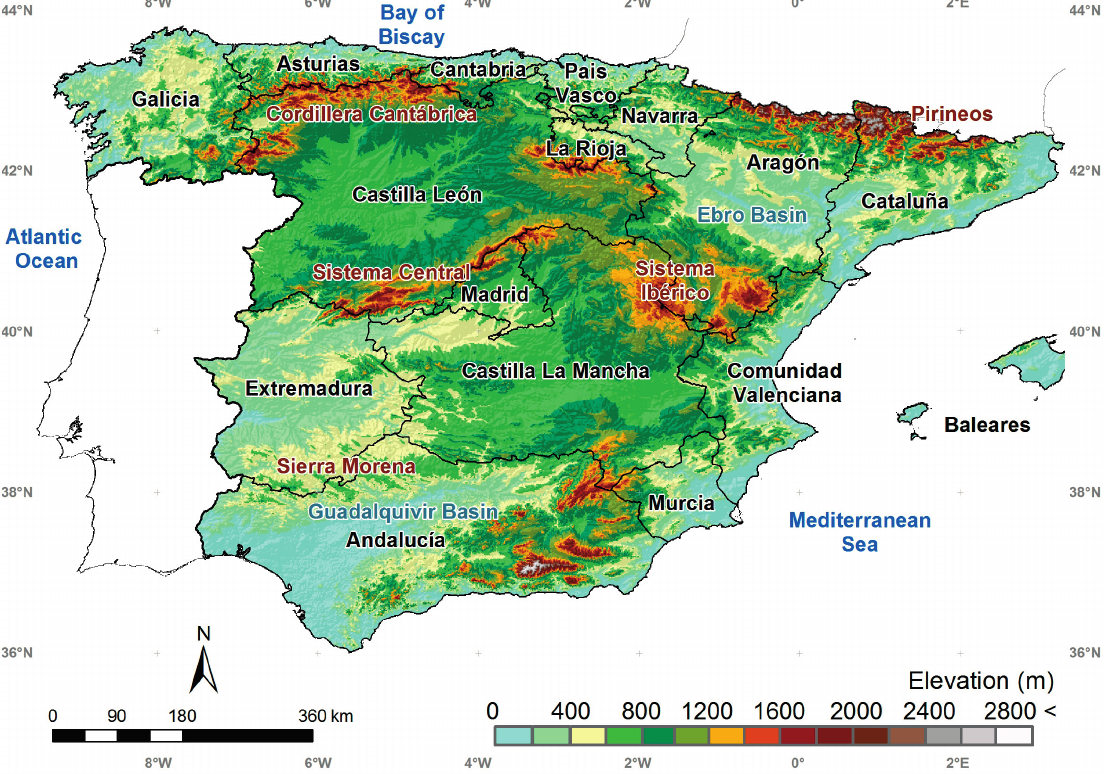
Figure 1. Study area with the localization of the regions, the Basin Rivers and the